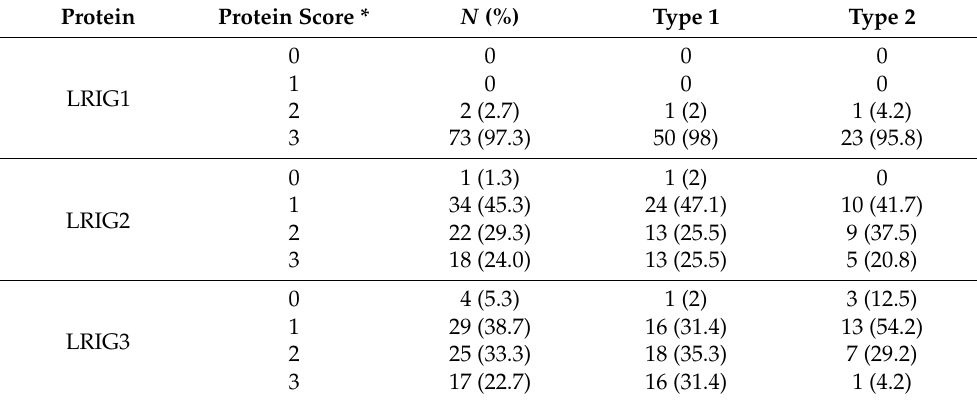
Table 2. Immunohistochemical staining for LRIG1, LRIG2, and LRIG3 ( n = 75).